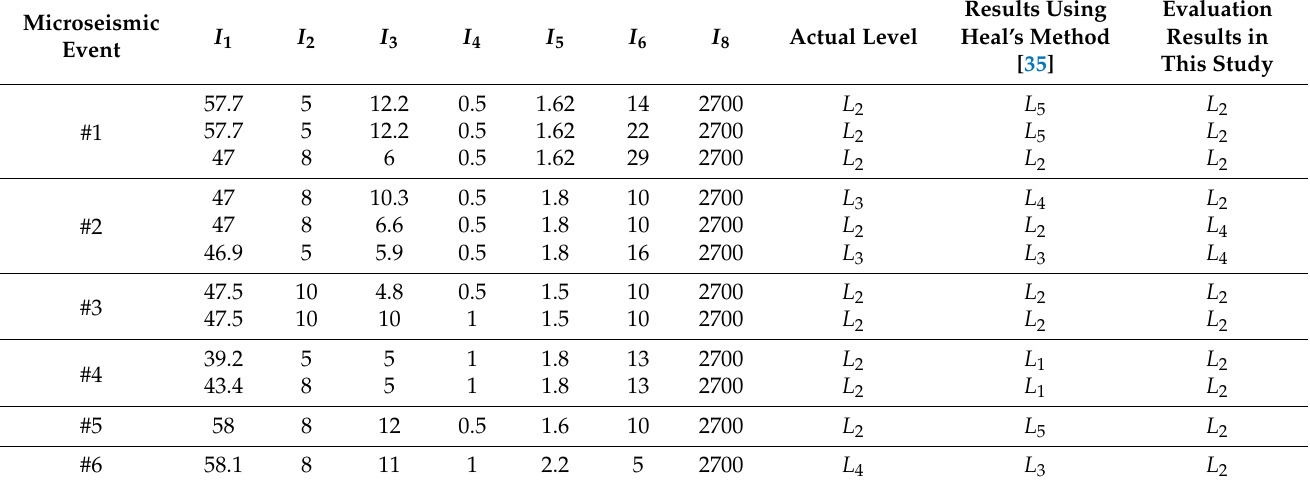
Table 1. Rockburst damage cases at Perseverance nickel